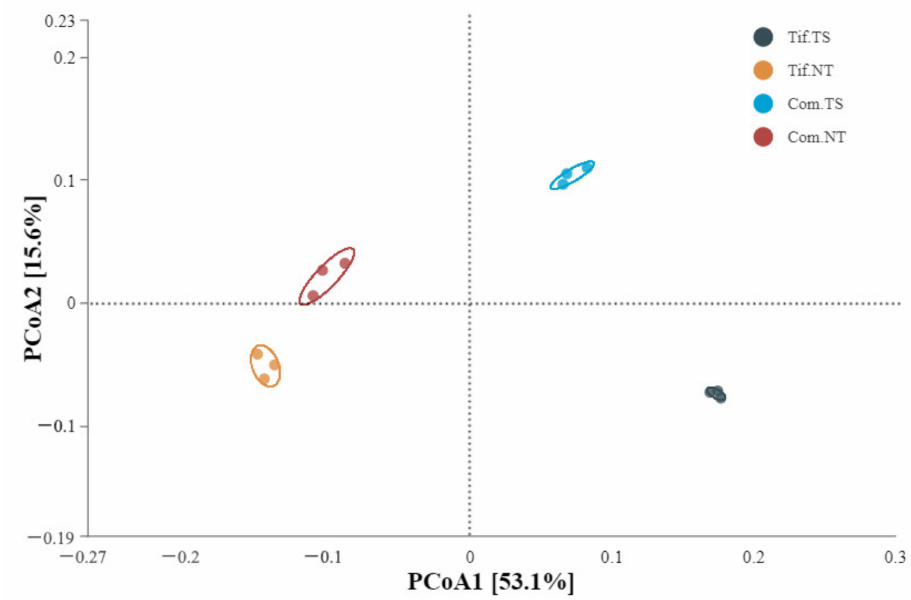
Figure 6. PCoA on structures of soil bacterial communities under traffic stress. Note: Tif.TS, Tifgreen bermudagrass with traffic treatment; Tif.NT, Tifgreen bermudagrass with non-traffic treatment; Com.TS, Common bermudagrass with traffic treatment; Com.NT, Common bermudagrass with non-traffic